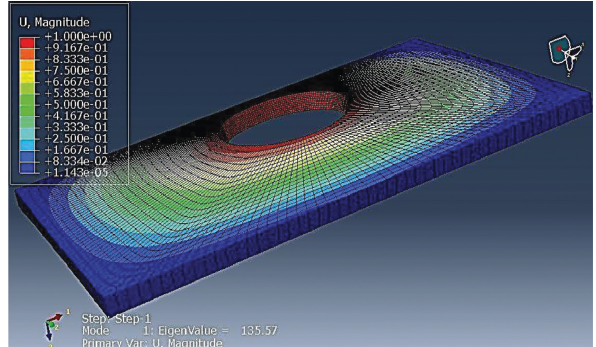
Figure 25: Tension mode for plate with 1/5 length to width ratio and 0/2 radius to width ratio without yielding.